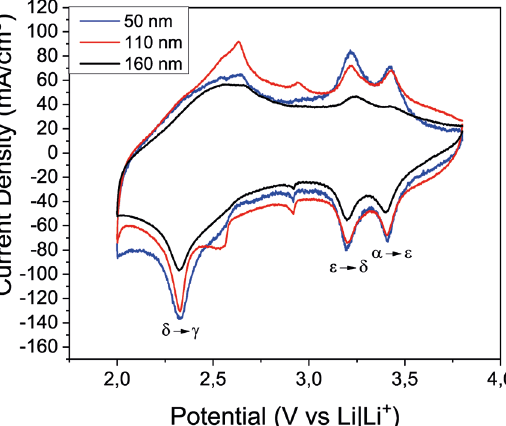
Figure 8. Banding structure scheme for non-intercalated V2O5 (a) and intercalated (b) [Adapted from Wu et al. 16 ].